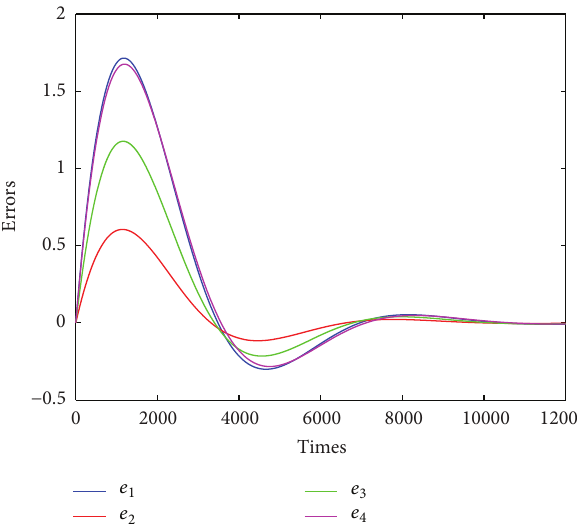
Figure 5: Synchronization errors 𝑒 1 , 𝑒 2 , 𝑒 3 , and 𝑒 4 between memris- tor chaotic oscillator system and hyperchaotic L¨u